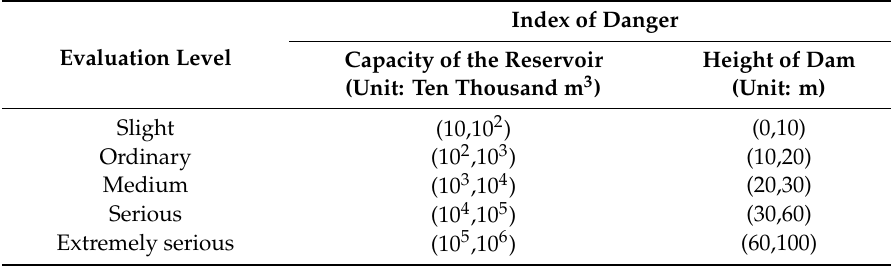
Table 2. Classification and grade suggestions for indexes of